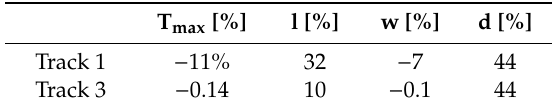
Table 3. Single-layer validation: the deviations between the reference model against the proposed model in terms of the melt pool dimension and maximum